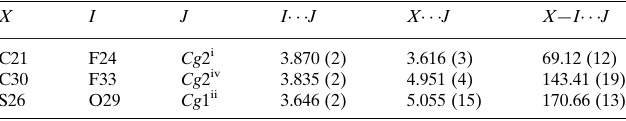
C—F (cid:2)(cid:2)(cid:2) (cid:3) and S—O (cid:2)(cid:2)(cid:2) (cid:3) interactions (A˚ , (cid:4) ). Cg 1 and Cg 2 are the centroids of the C9/N10/C11–C14 and C1–C4/C11/C12 rings, respectively.